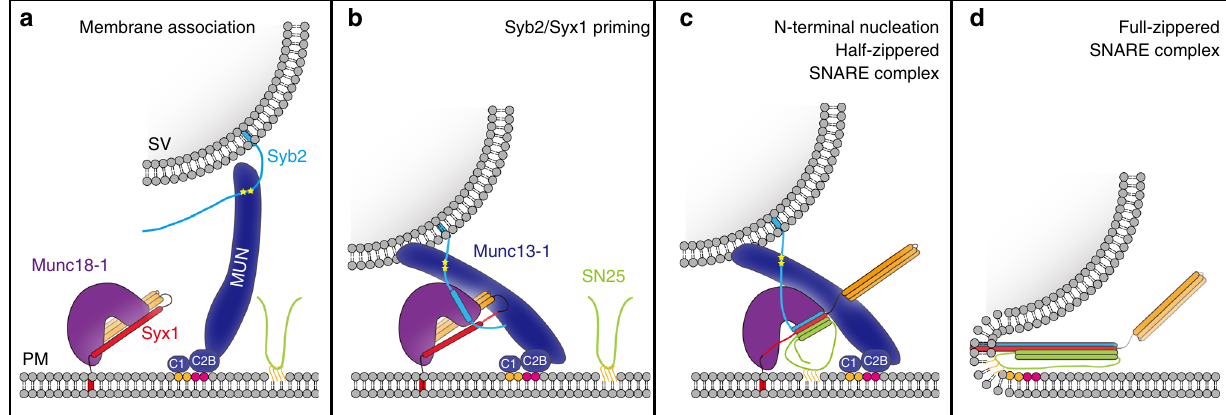
Fig. 8 Working model of Munc18 – Munc13 route to SNARE complex assembly. a The Syb2/MUN interaction and the C 1 -C 2 B/DAG-PIP 2 interaction might pre-align synaptic vesicles with the plasma membrane, thus enhancing the binding reactivity between Syb2 and the Munc18-1/Syx1 complex. Yellow pentagrams represent the hydrophobic (W89/W90) and charged (R86/K87) residues in the Syb2 linker region. Orange and magenta spheres indicate DAG and PIP 2 , respectively. b The Syb2/MUN interaction, in coordination with the Munc18-1/Syx1/MUN interaction, allows binding of Syb2 to the extended conformation of domain 3 and thereby primes Syb2 and Syx1. c Munc18-1 and Munc13-1 proofread SNARE N-terminal nucleation with the entry of SN25. A half-zippered SNARE assembly releases Syx1 from Munc18-1 clamping, thus gating the transition to the SNARE complex. d Full zippering of the